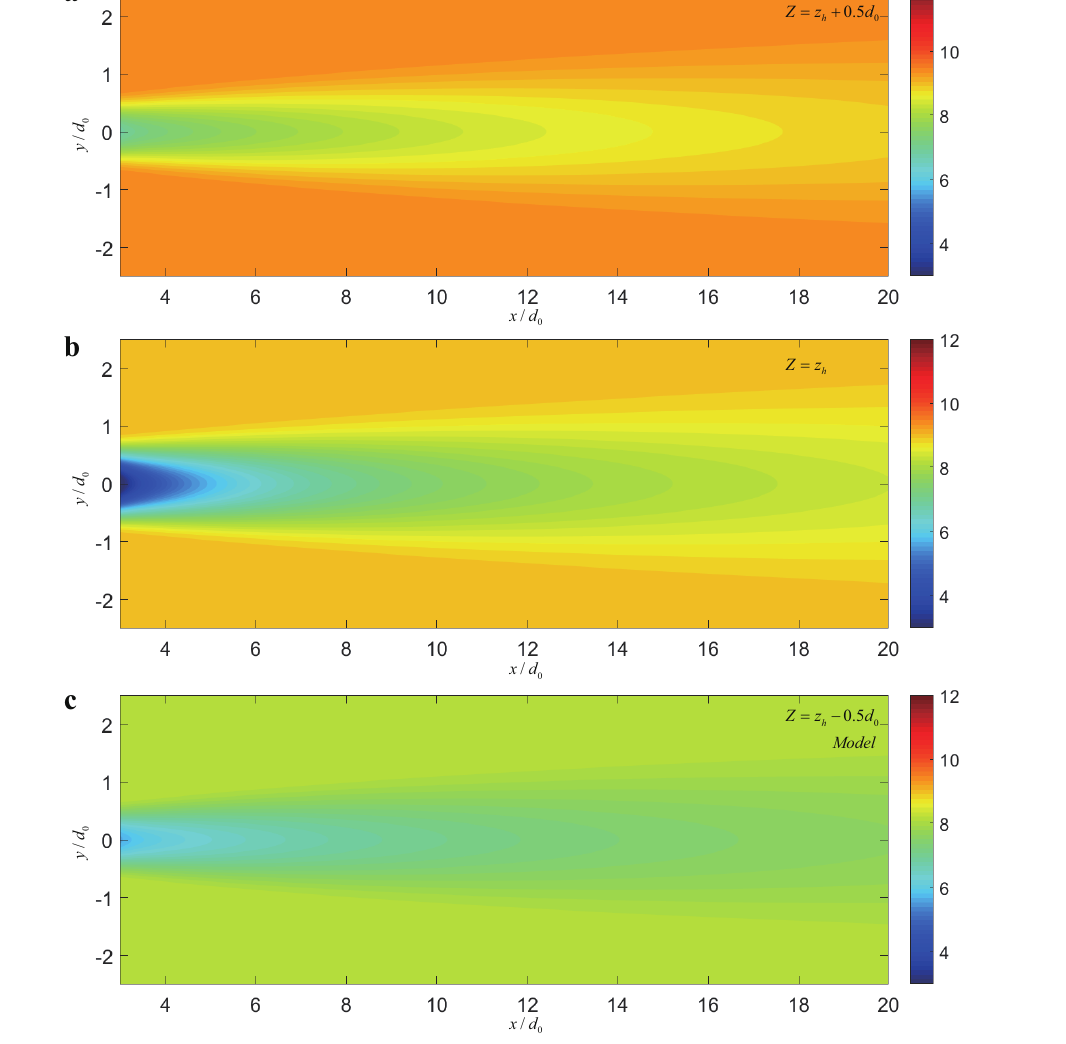
Figure 12. X – Y views of the streamwise velocity estimated by the model: ( a ) Z = z h + 0.5 d 0 ; ( b ) Z = z h ; ( c ) Z = z h − 0.5 d 0